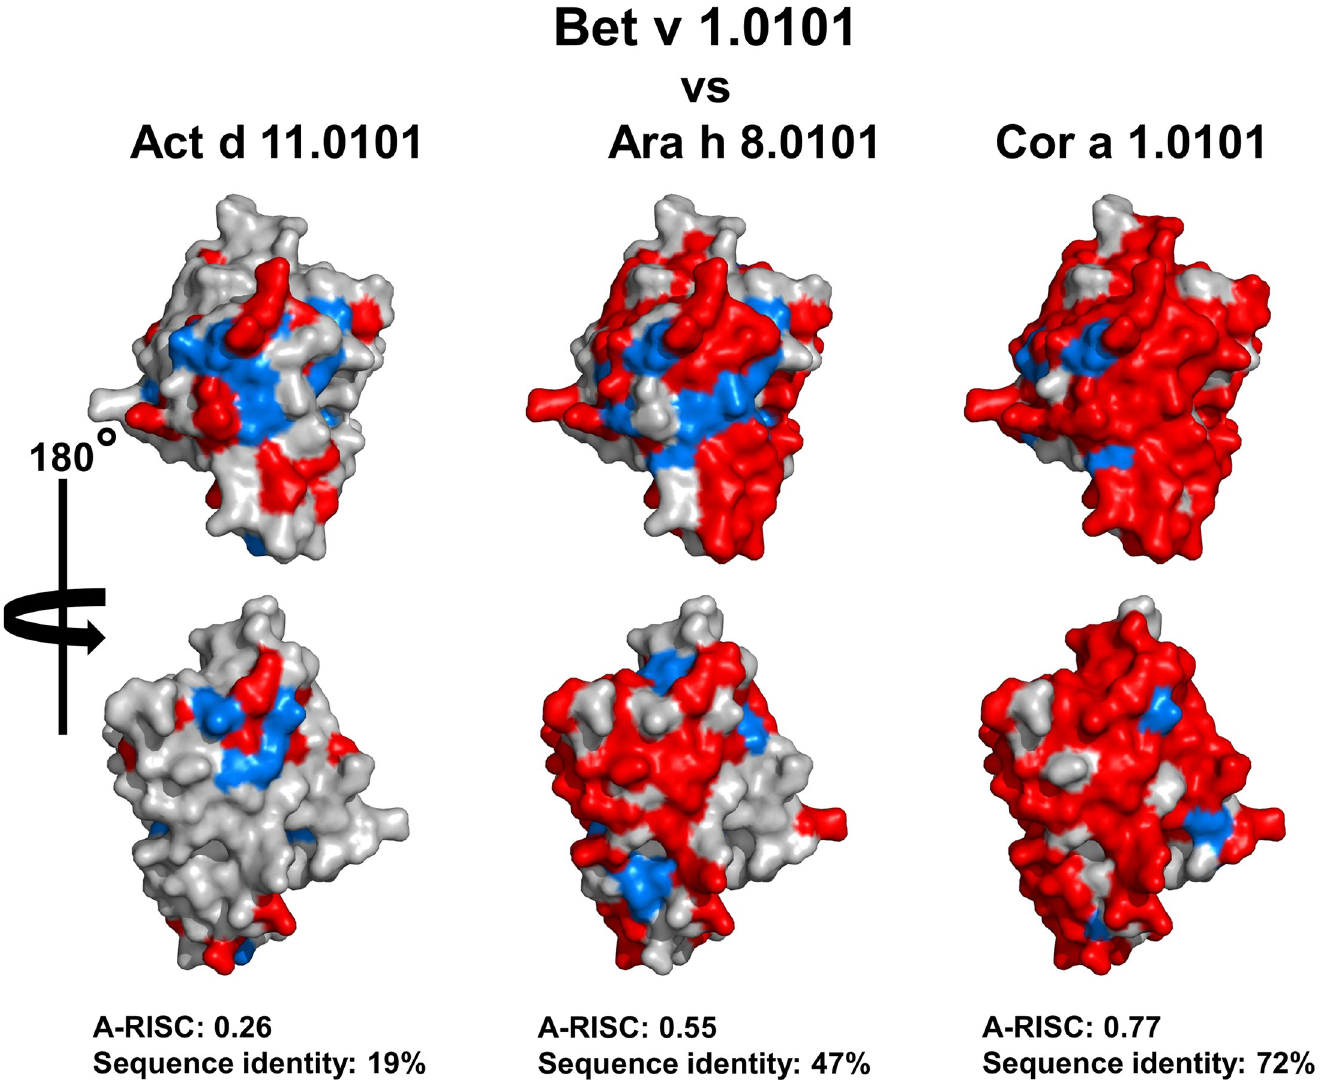
Fig 28. Comparison of Bet v 1.0101 with Act d 11.0101, Ara h 8.0101 and Cor a 1.0101. Identical amino acids (red) mapped on the structure of Bet v 1. Residues marked in light blue correspond to the difference between similar and identical